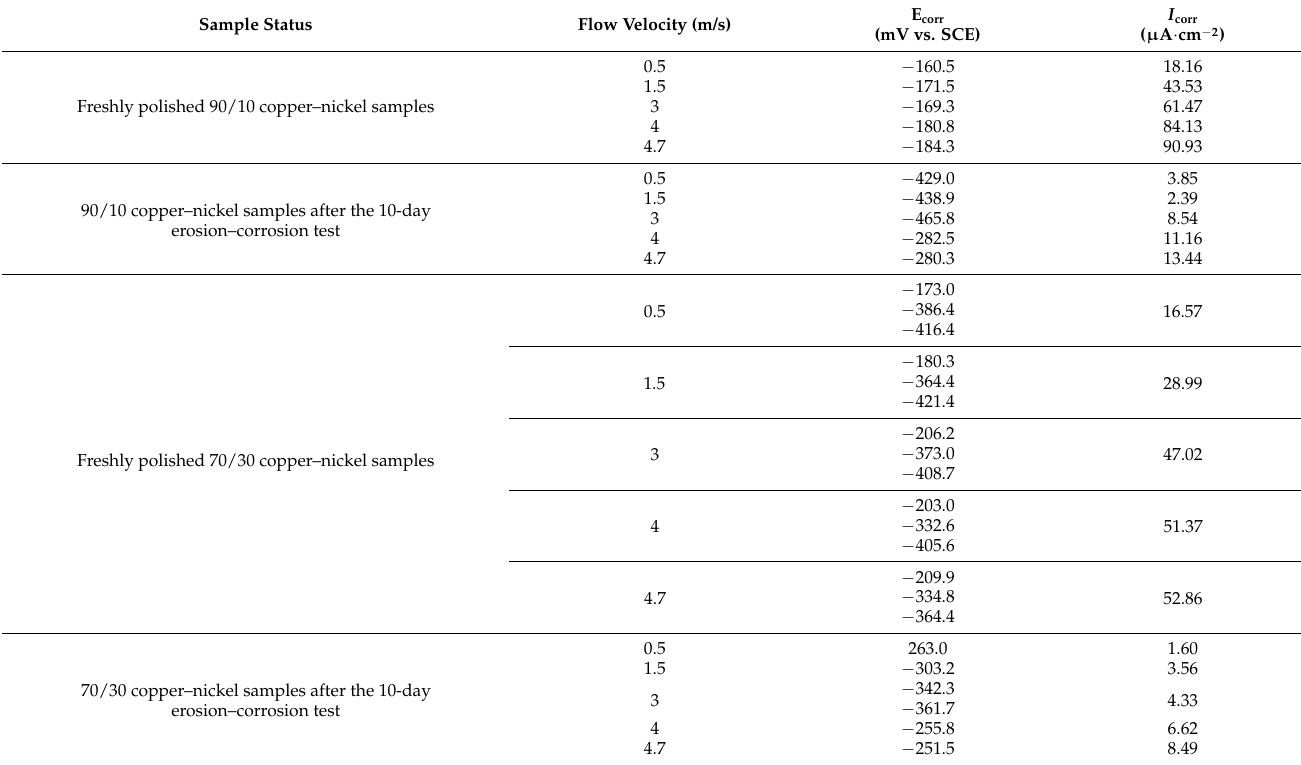
Table 4. Electrochemical parameters obtained from the fitting of the polarization curves of 90/10 copper–nickel alloys and 70/30 copper–nickel